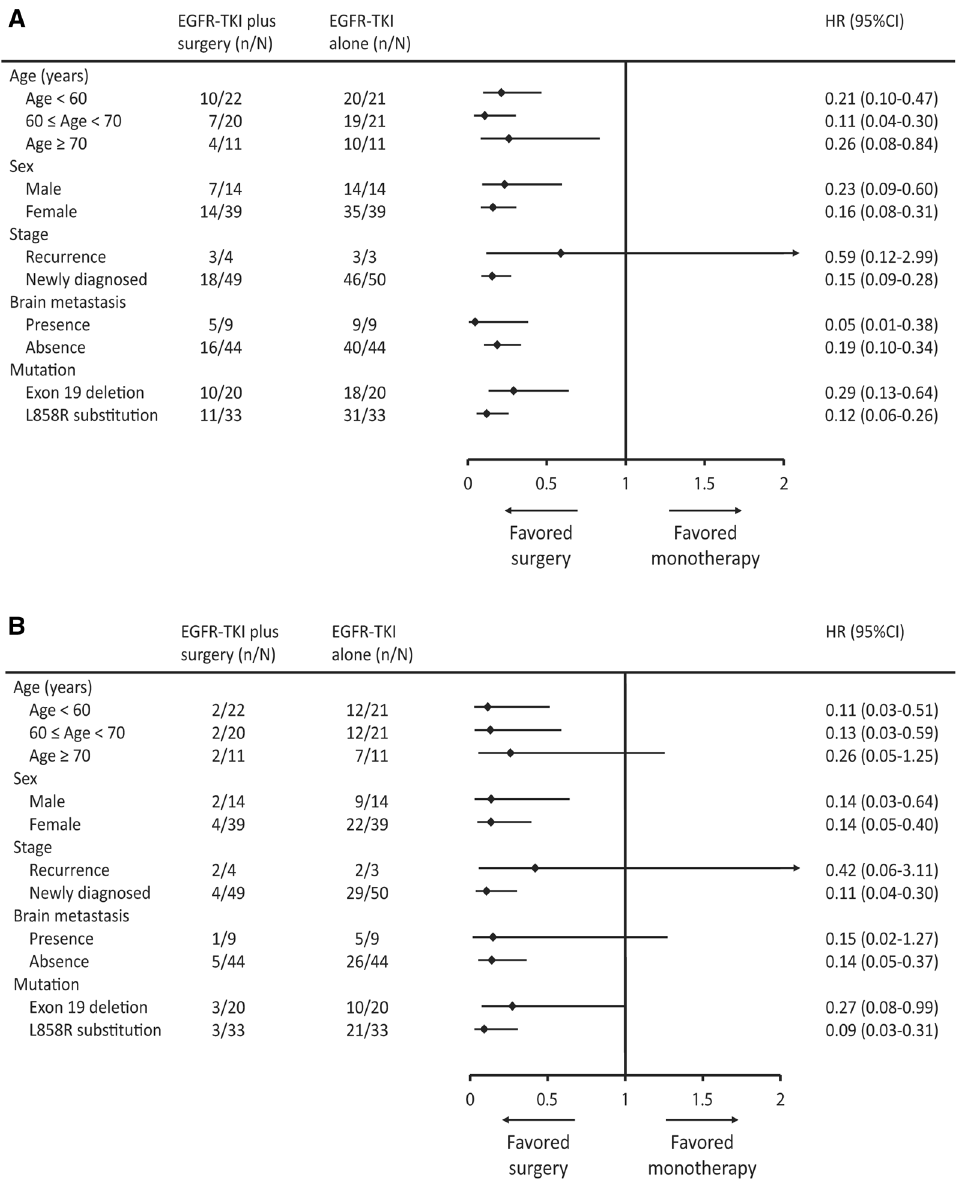
Figure 4. Subgroup analyses of progression-free survival ( A ) and overall survival ( B ) by baseline